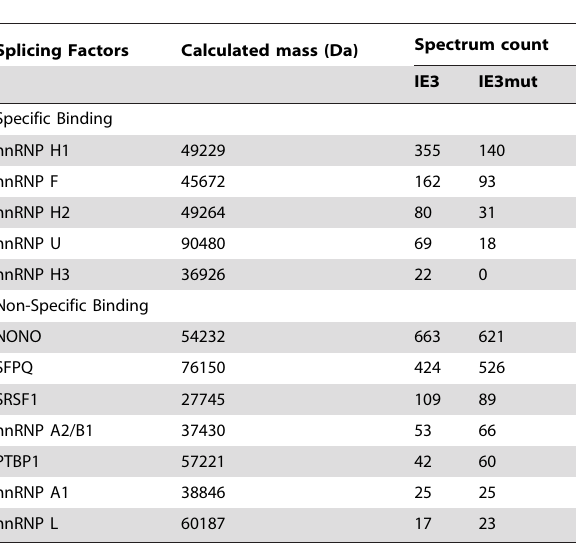
Figure 2D. Over expression or knockdown of hnRNP A1 and hnRNP F modulates inclusion of exon 11 of an IR minigene To test whether hnRNP A1, -H, or -F can regulate exon 11 inclusion, we co-transfected HepG2 cells with the hIR minigene and expression vectors for hnRNP A1, -F or -H. Analysis of exon 11 splicing of the minigene construct indicated that over expression of hnRNP A1 significantly decreases and hnRNP F significantly increases the inclusion of exon 11 (Figure 3A). Over-expression of hnRNP H does not have any effect on exon 11 inclusion in HepG2 cells (Figure 3A). As hnRNP A1 and -F appeared to play opposite roles in splicing of exon 11 despite binding to similar sequences, we titrated the hnRNP A1 and hnRNP F expression plasmids on the IR minigene. Transfection of increasing amounts of hnRNP F expression plasmid in face of a constant quantity of hnRNP A1 causes an increase in the inclusion of exon 11, compared to hnRNP A1 alone (Figure 3B). Conversely, transfecting increasing amounts of hnRNP A1 expression plasmid in the face of a constant quantity of hnRNP F causes a dose-dependent decrease in the inclusion of